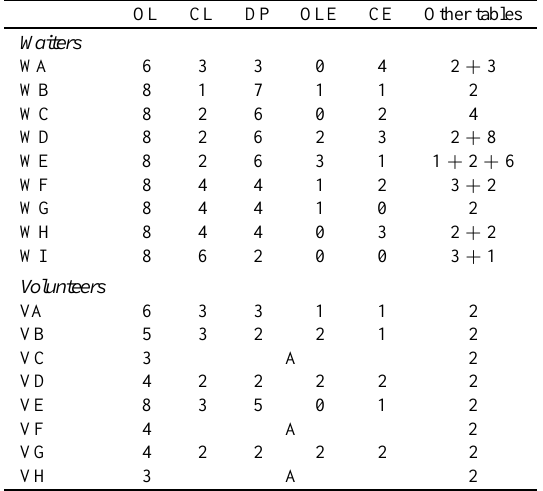
Table 1 Waiters and normal volunteers’ performances during no change and change of seats